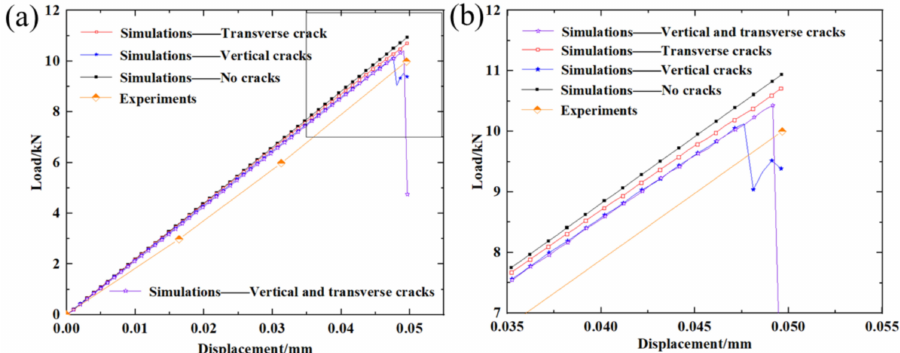
Figure 12. Load–displacement curves obtained from finite element analysis and experiments.( a ) The whole loading process; ( b ) The section approaching